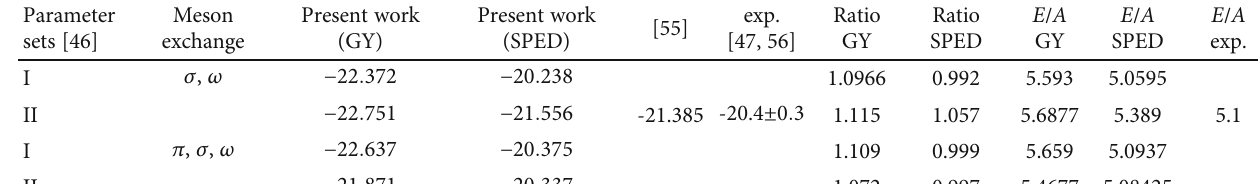
Table 3: The ground-state energy of 4 He with the aid of Table